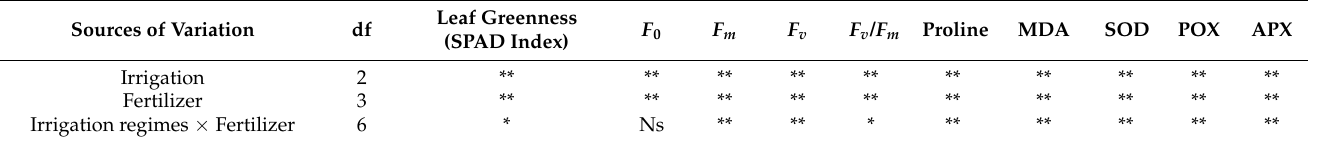
(Figure 2d). In addition, co ‐ application of Cs ‐ NPs+ Myco ‐ Root strongly enhanced the F 0 value, which was 35.6% higher than the control (Figure 2e). Table 3. Results of variance analysis for the effect of different irrigation levels and fertilizer sources on the physiological characteristics of L. iberica .